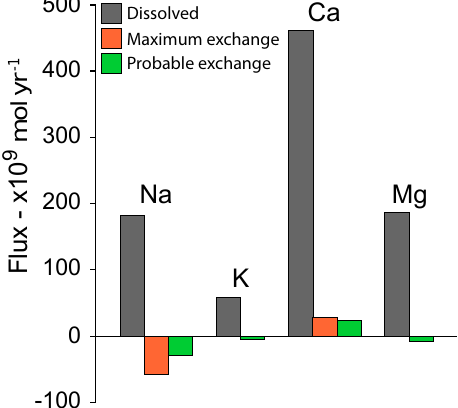
Figure 5. Maximum cation exchange fluxes (for a complete ex- change of riverine Ca 2 + for Na + ) and more probable exchange fluxes (partial exchange of riverine Ca 2 + for Mg 2 + , K + and Na + ) based on exchange data of Sayles and Mangelsdorf (1977, 1979) of G&B sediments. These exchange fluxes are compared to the to- tal dissolved fluxes exported by the G&B as estimated by Galy and France-Lanord